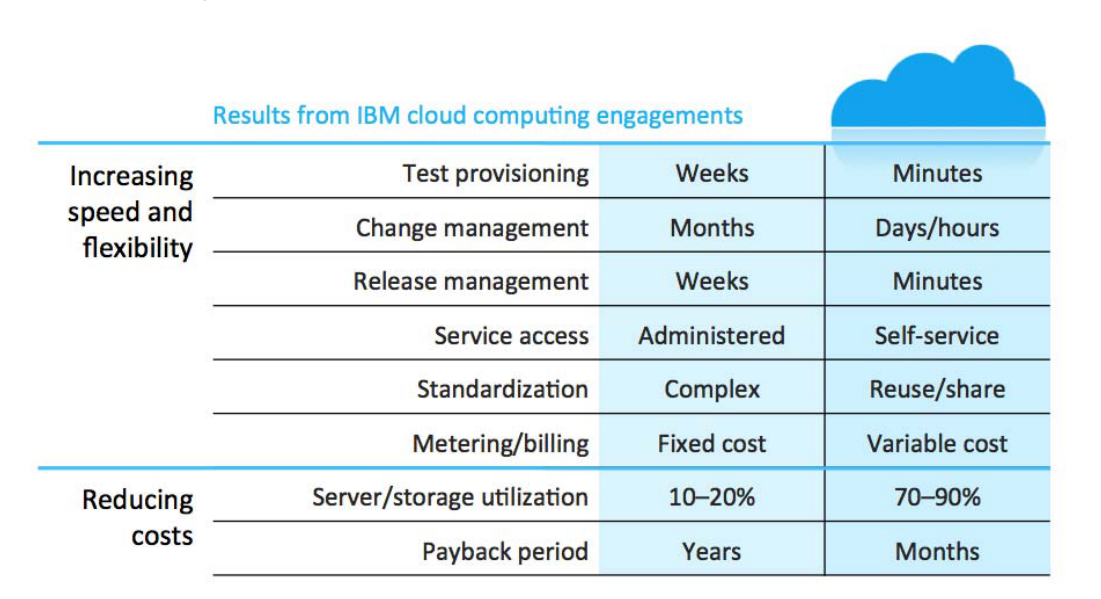
Fig. 1. IT benefits of Cloud